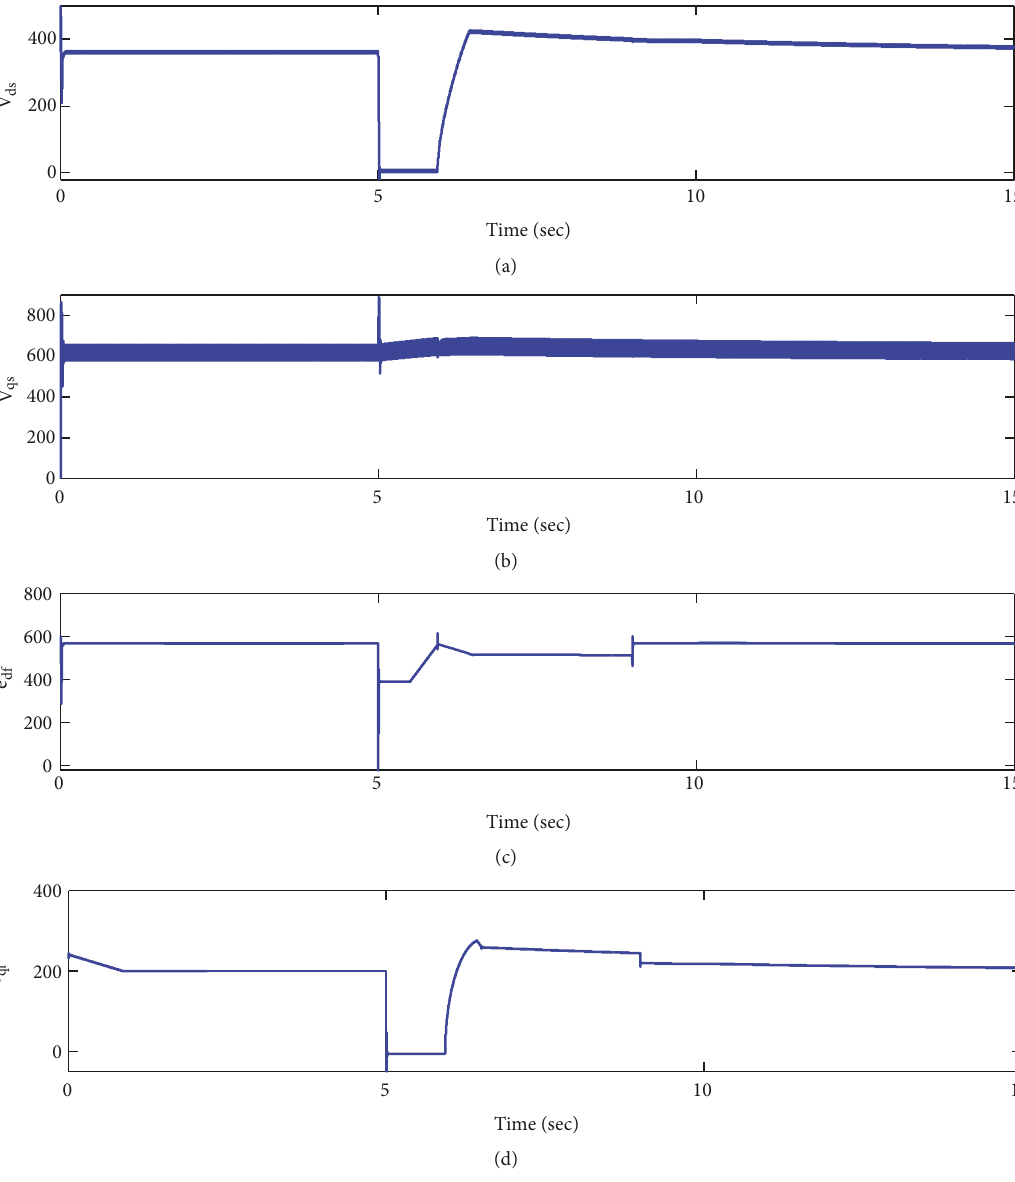
Figure 10: The d-q axis input controller signals for (a) and (b) MSC, (c) and (d) GSC, in